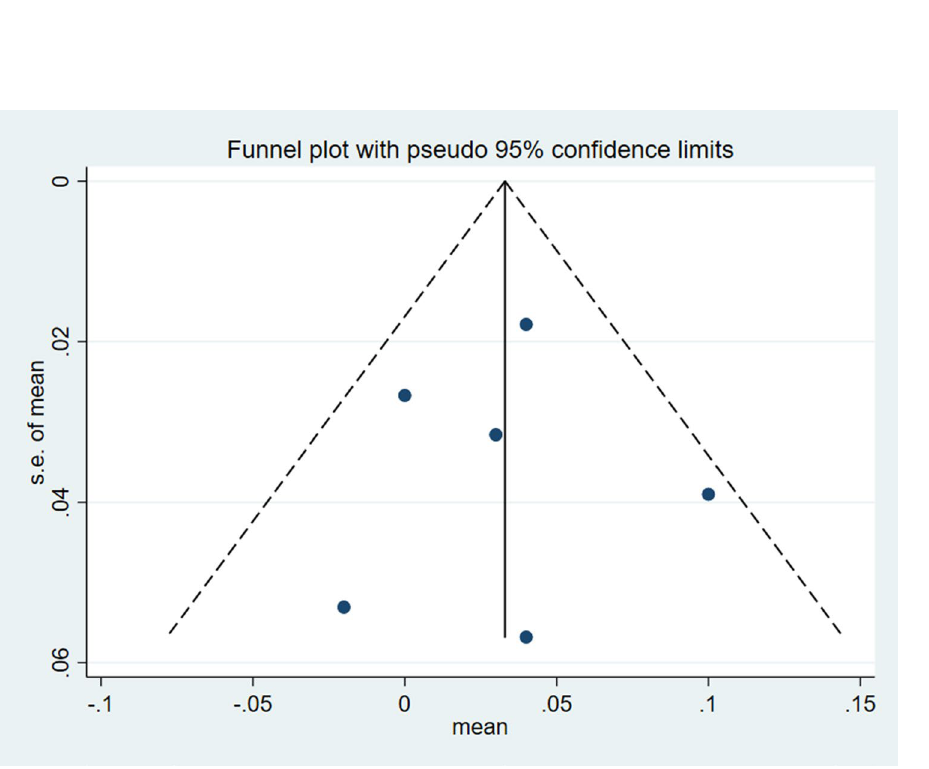
Figure 6. Funnel plot of publication bias for the effect of resistance exercise on the gait